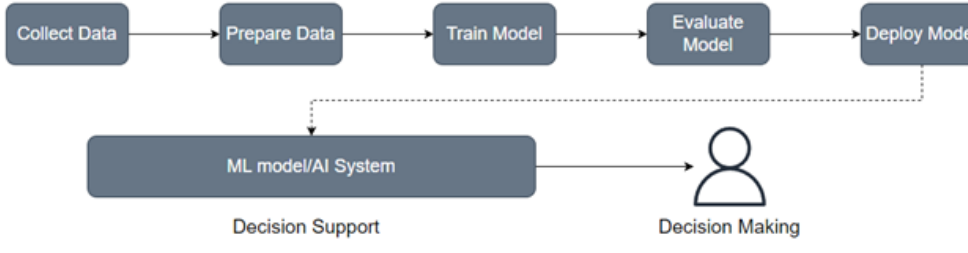
Figure 2. The Model Building Process in Machine